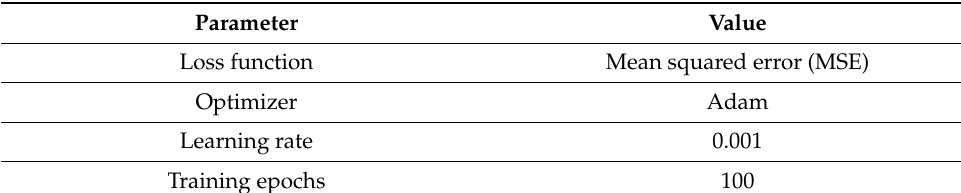
Table 2. Network Parameters.